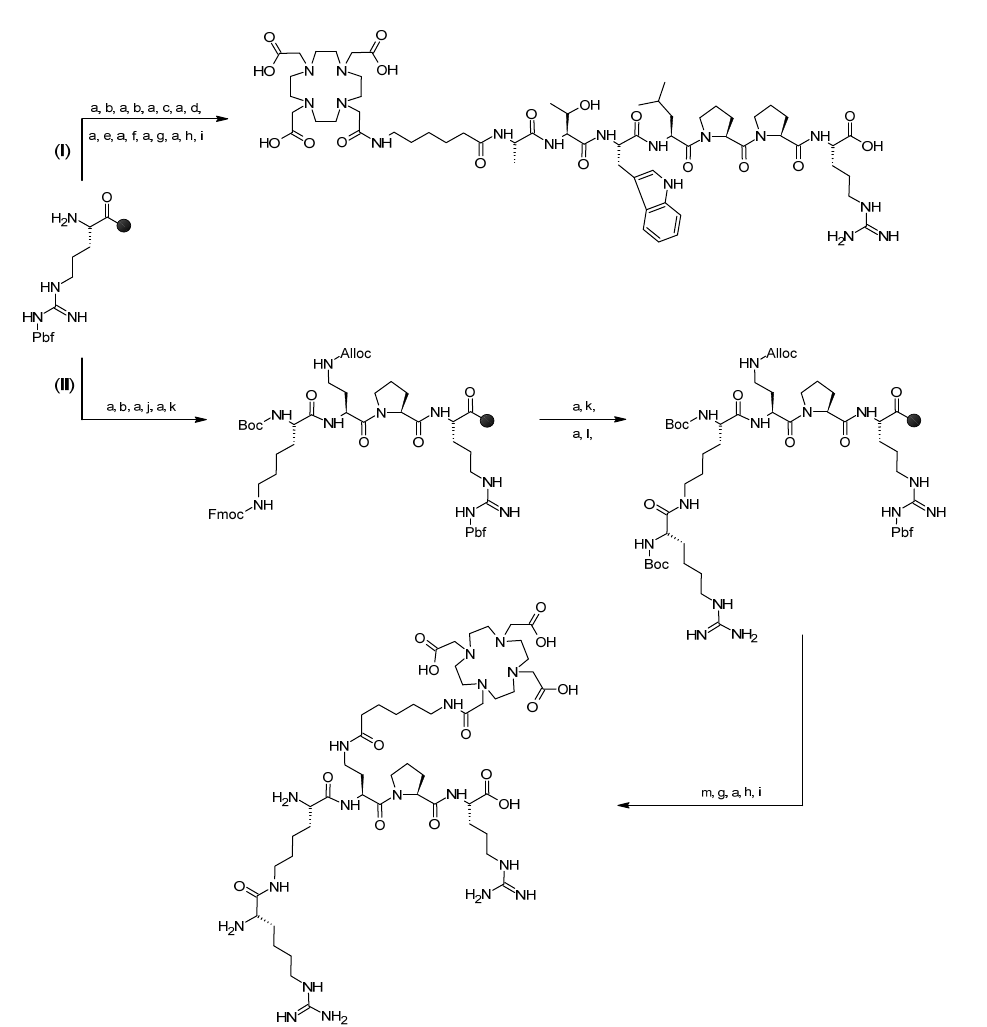
Scheme 1. Synthesis strategy of conjugate 1 (path I) and 2 (path II) by SPPS method. a—